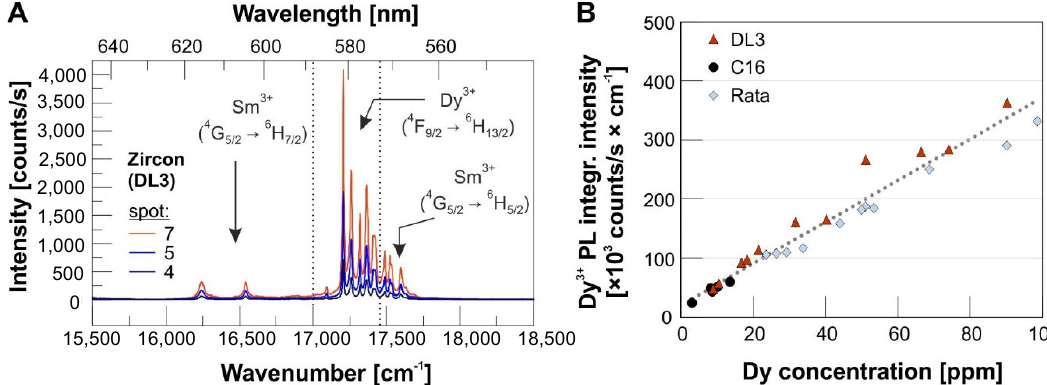
Figure 6. ( A ) Laser-induced PL spectra (laser-excitation wavelength λ exc = 473 nm) obtained from three different measurement spots on the zircon sample DL3 (spots 4, 5, and 7; Figure 5). ( B ) The integrated intensity of the most intensive emission of Dy 3+ in the spectral range 17,000–17,450 cm −1 (see dotted lines in sub-image ( A )) from multiple spots on samples DL3, C16, and Rata plotted against the Dy trace-element concentration as obtained from LA–ICP–MS (Table S1). Linear regression from the data pairs PL vs. Dy conc. (R² = 0.95) was used to calibrate hyperspectral maps presented in Figure 5 .